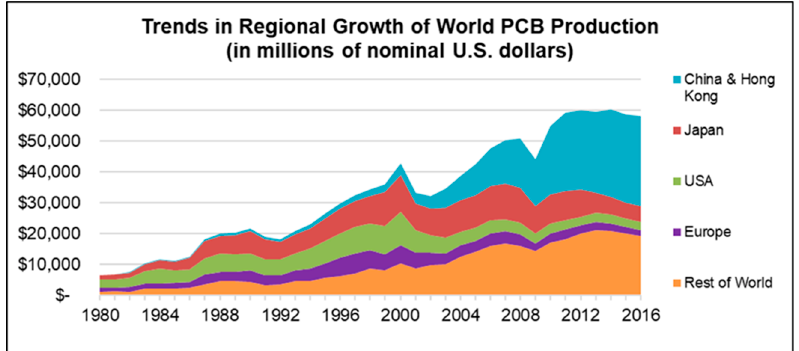
Figure 1. Trends in regional growth of world PCB (printed circuit boards) production (1980–2016). Reprinted with permission from [1]; Copyright 2016 IPC.